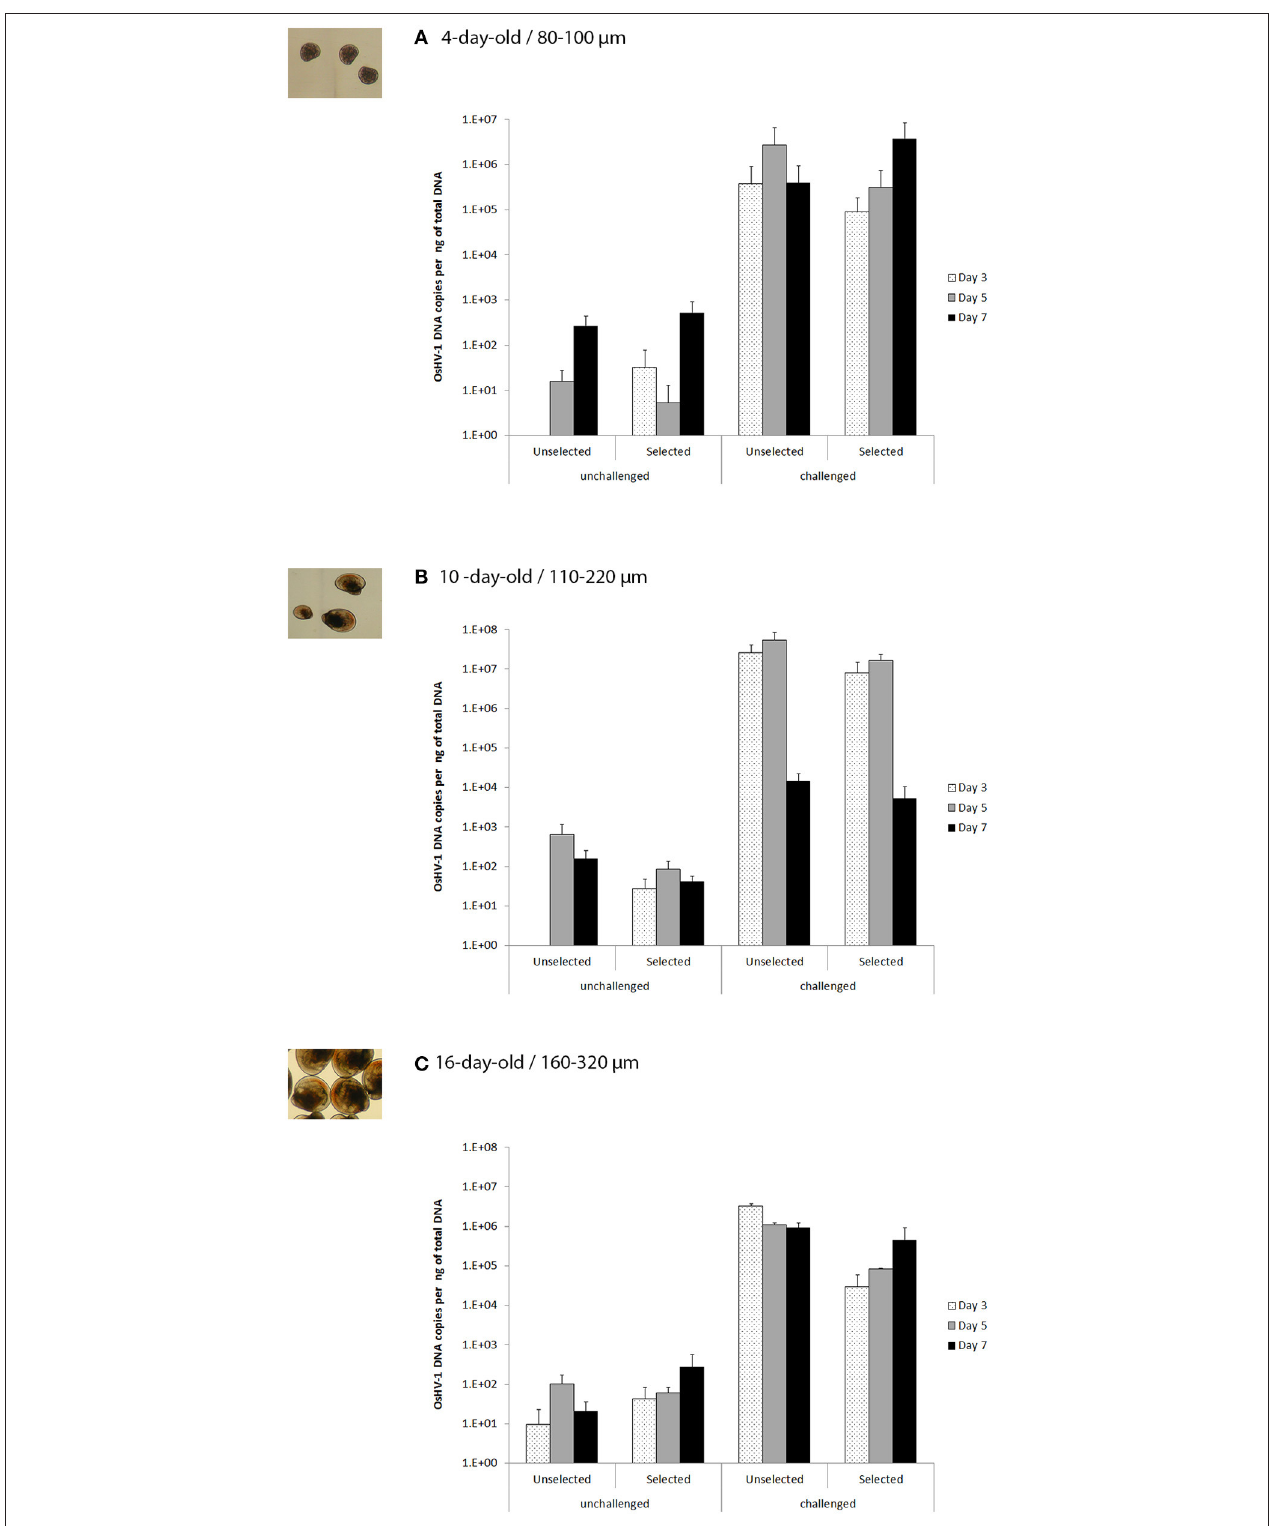
FIGURE 4 | OsHV-1 DNA copies per ng of total DNA (% + SD) in unselected and selected larvae on days 3, 5, and 7 post-exposure for the unchallenged and challenged conditions (0 and 10 + 6 OsHV-1 DNA copies L − 1 , respectively) in trial 2a (A), trial 2b (B), and trial 2c (C) corresponding to 4, 10, and 17 day-old larvae, respectively and 80–100, 110–200, and 160–320 µ m larvae, respectively.